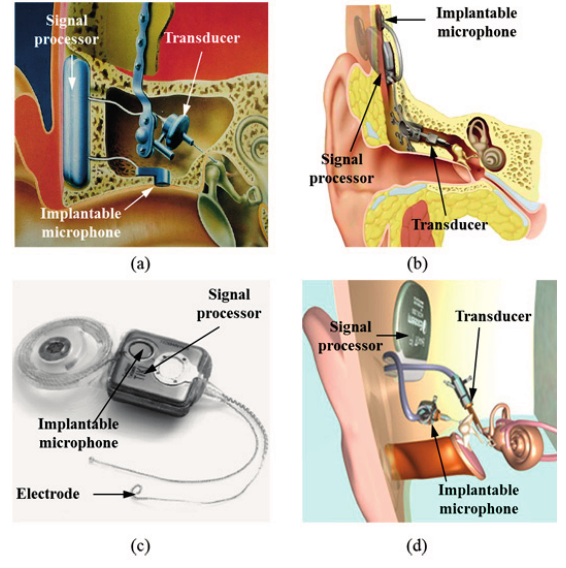
Figure 1. Microphone technologies used for fully implantable hearing aids: ( a ) TICA (Implex, Munich, Germany) [9]; ( b ) Carina (Cochlear, Sydney, Australia) [5]; ( c ) TIKI (Cochlear, Sydney, Australia) [4]; ( d ) Esteem (Envoy, Saint Paul, MN, USA)